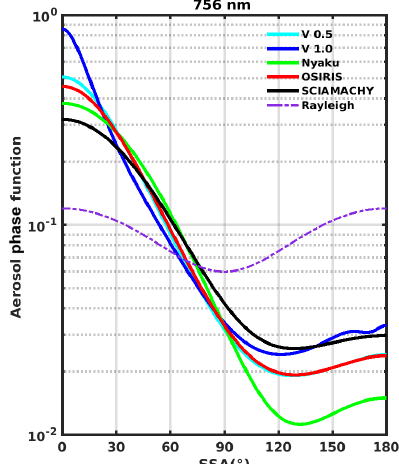
Figure 10. The aerosol phase function at 756nm as a function of SSA (or (cid:50) ) for the aerosol size distributions listed in Tables 1–2.